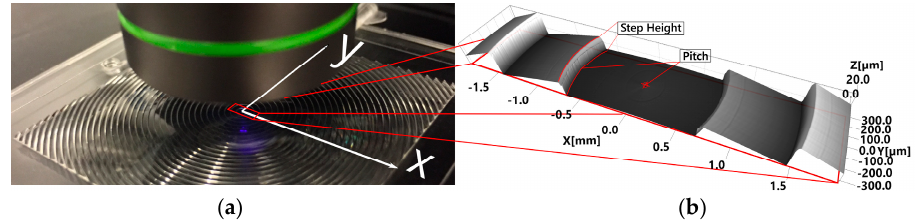
Figure 5. 3D measurements performed with the laser scanning confocal microscope: ( a ) Measurement set-up using the 20× objective; ( b ) Resulting 3D view of the sampled image. Table 1. Measurement set-up of the laser scanning confocal microscope for the studied Fresnel lens. Table 2. Step height measurement uncertainty budget for COP and PMMA in injection molding (IM) and ICM, of a nominal grooves’ height of 17.3 µm. Measurements are calibrated with a gauge step of 14.45 µm.